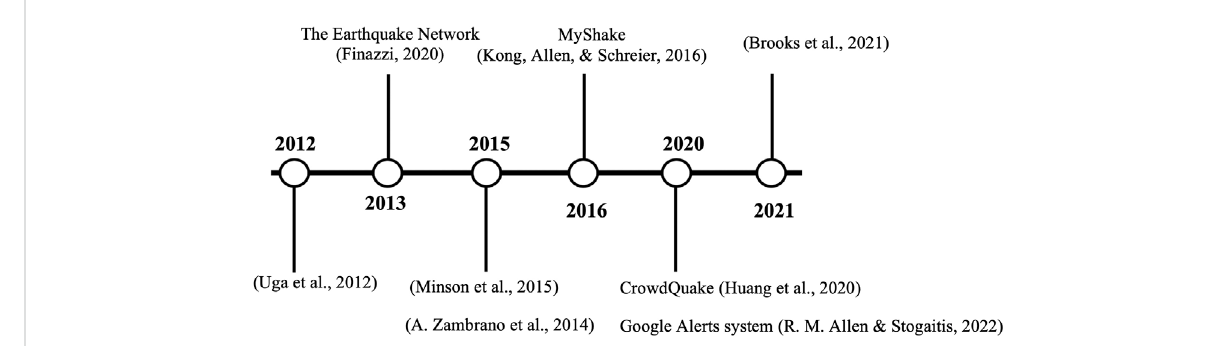
FIGURE 3 Timeline of smartphone-based EEWSs according to their year of